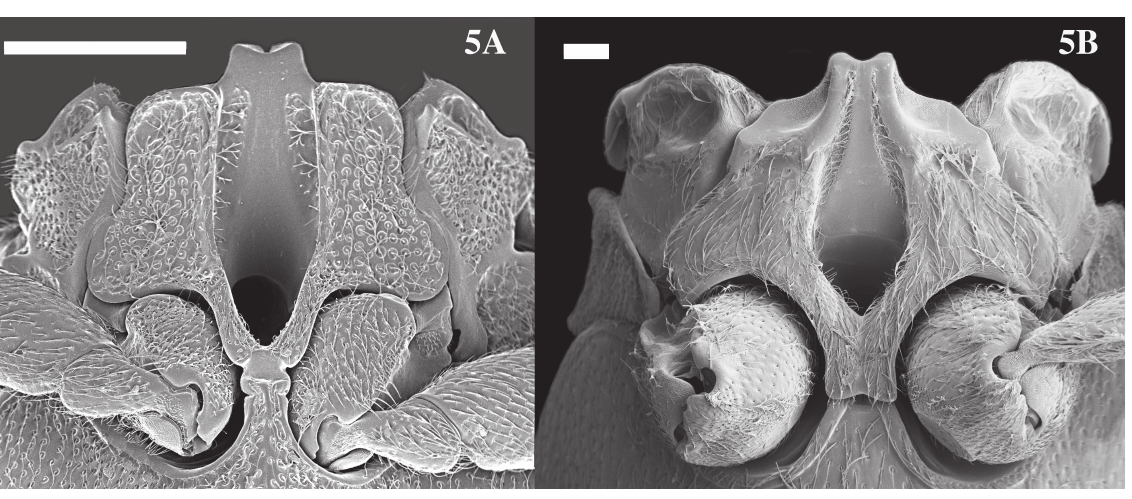
Fig. 5. sEM photographs of mesoventral cavity. A . Sharon amoenus (Philippi, 1861) comb. nov. B . Hemi- crepidius memnonius herbst, 1806 . scale bars =